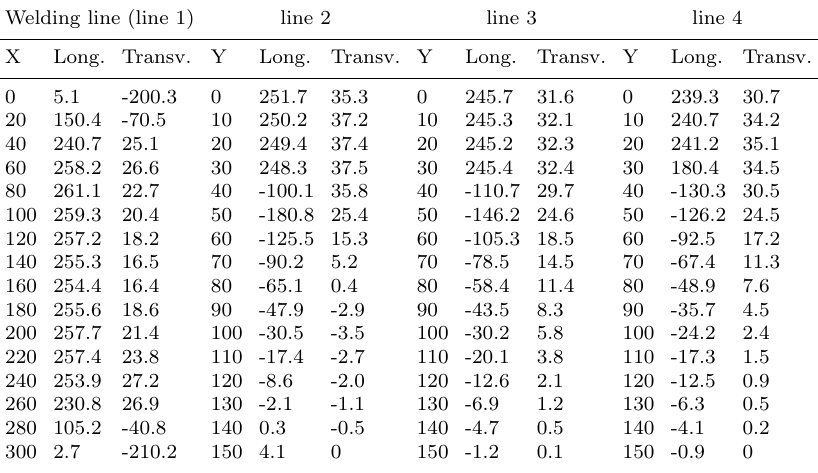
Table 3. Longitudinal and transverse residual